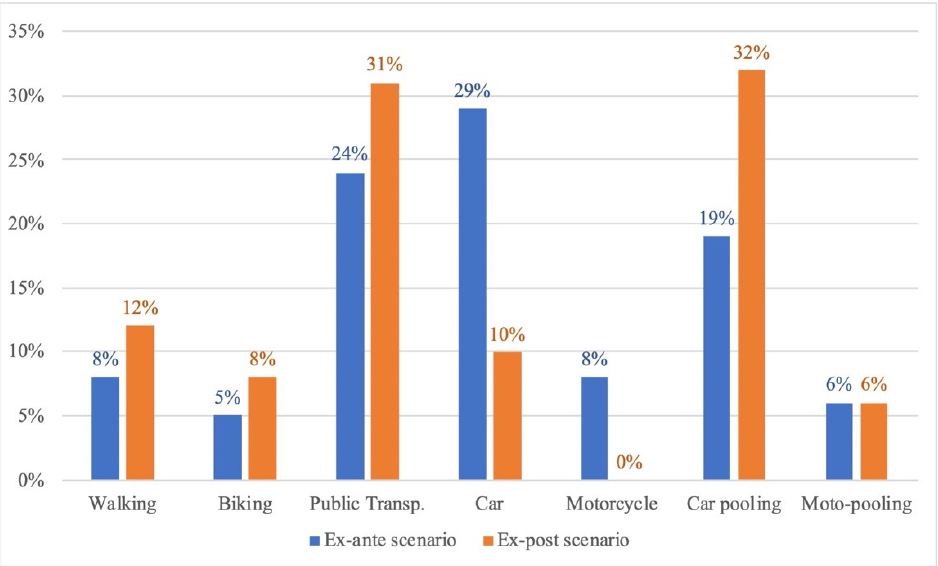
Figure 5. Aggregate percentages of kilometers covered by the mobility means in the actual ex-ante (0) and improved ex-post (1) scenarios, in reference to the total distance traveled by all commuters.